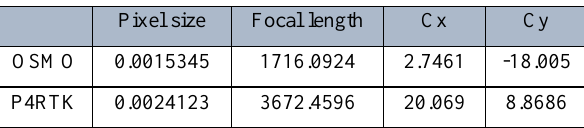
Table 1. Self-calibrated interior orientation parameters of OSMO and P4RTK by GCPs. The unit of pixel is mm and the others are pixels.